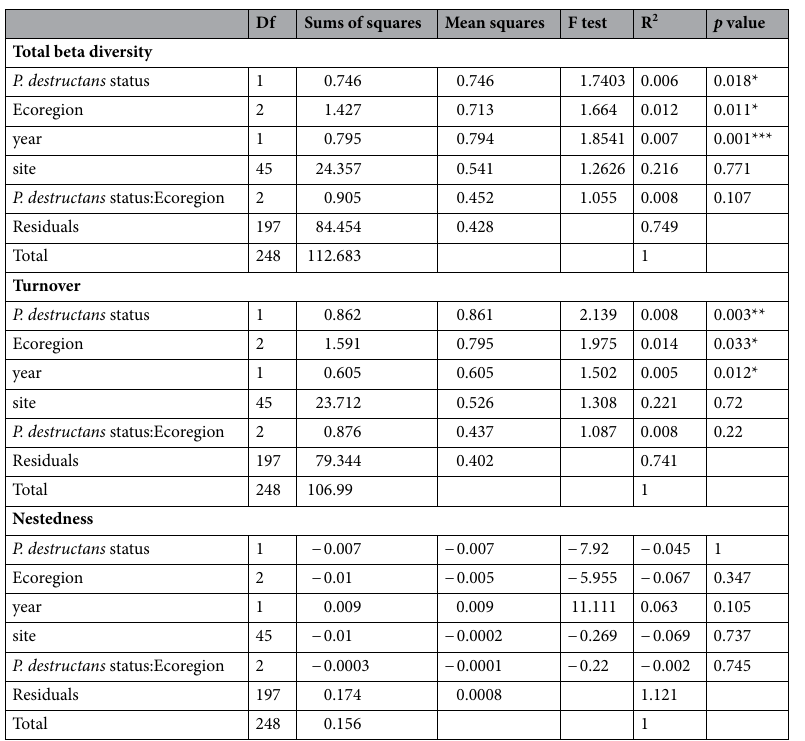
Table 2. PERMANOVA results for total beta diversity (SOR), the turnover component of beta diversity (SIM), and the nested component of beta diversity (SNE). There is a significant difference between P. destructans status, Ecoregion, and year for both SOR and SIM ( p <